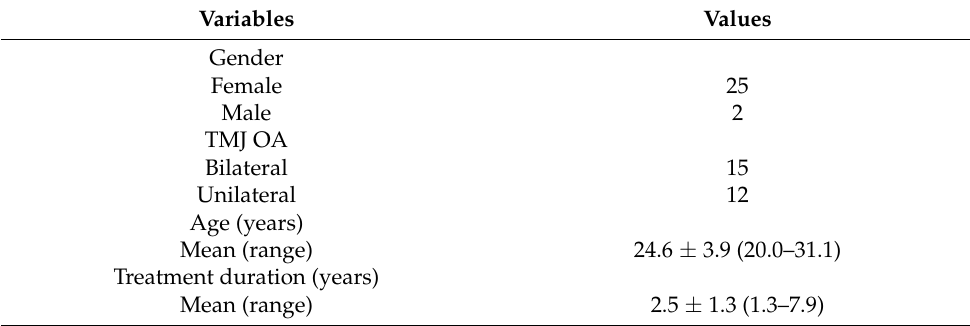
Table 1. Patients’ characteristics ( n = 27).